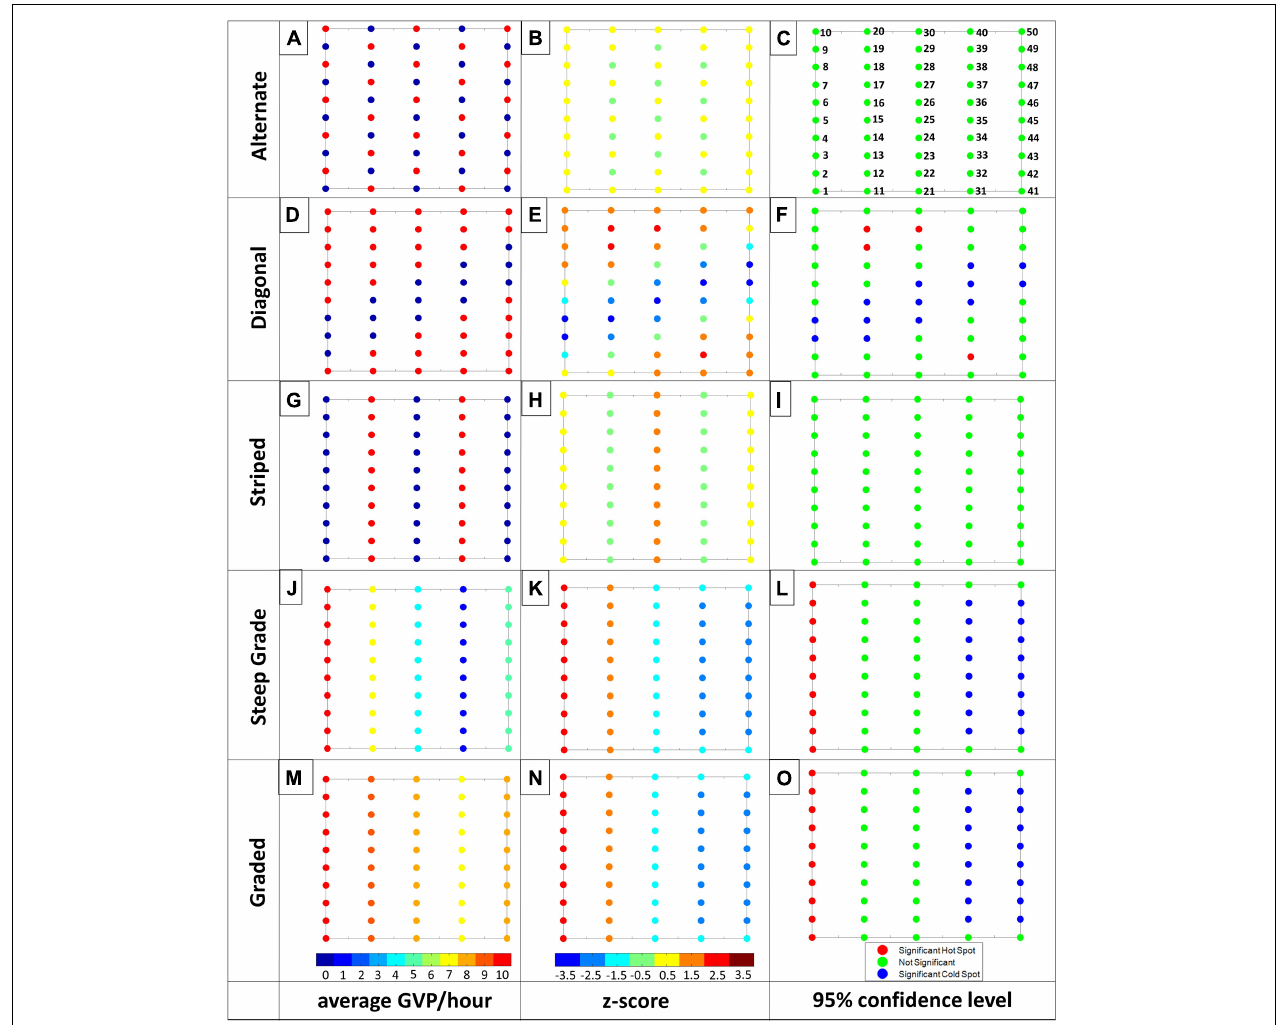
FIGURE 3 | Visualization of the Gi* results for the Alternate, Diagonal, Striped, Steep Grade, and Graded Patterns (top to bottom). From left to right: first column: average GVP per hour with color bar ranging from 0 (dark blue) to 10 (red); second column: Gi* z-statistic with color bar ranging from –3.5 (dark blue) to 3.5 (dark red); third column: 95% confidence level, where red indicates a significant hot spot and blue indicates a significant cold spot, while green is not significant. For ease in displaying, individual hydrophone values were rounded to the closest number on the color bar for columns one and two. The numbers provided on Figure 3C correspond to hydrophones discussed in the Results. Letters associated with each plot are used for ease in referencing individual plots in the text.